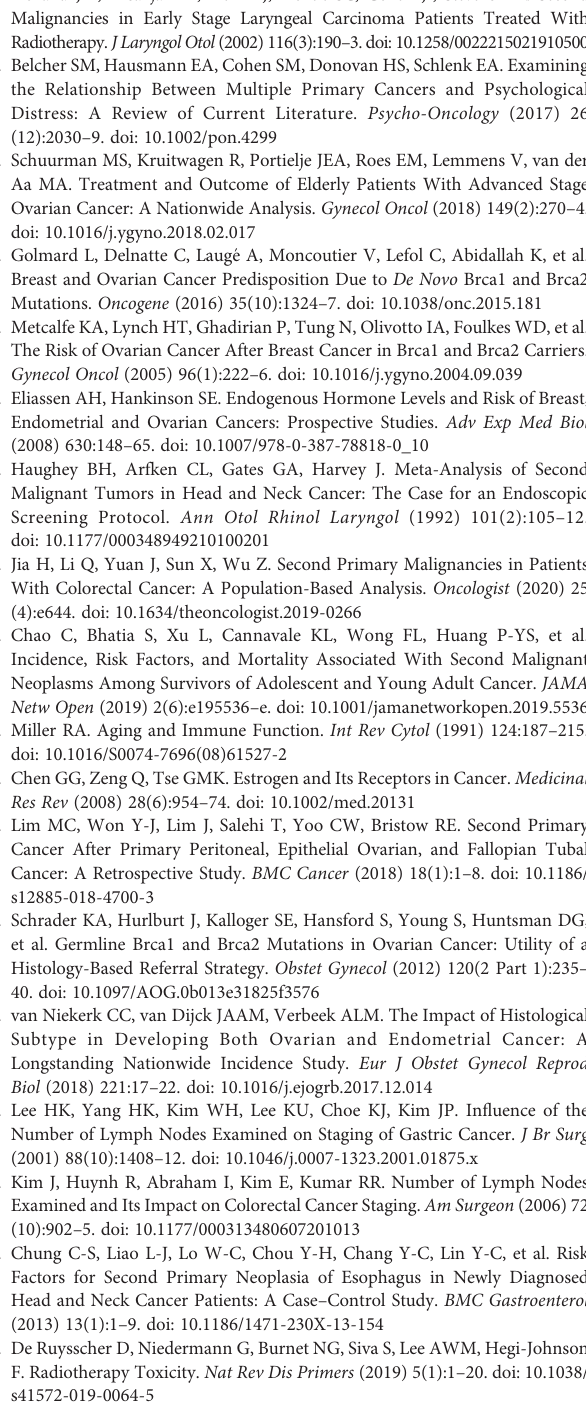
Supplementary Figure 1 | Top 10 most frequent sites of developing second primary malignancies in early-stage ovarian cancer patients. Supplementary Figure 2 | Calibration curves for 3-year predicted vs. observed probability of developing second primary malignancies estimated by the Fine and Gray model.